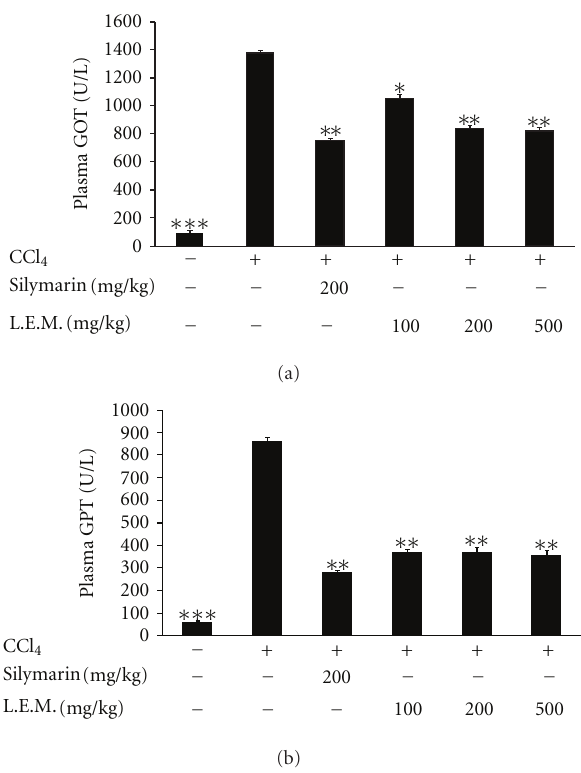
Figure 2: E ff ect of LEM on plasma GOT and GPT levels in CCl 4 - treated rats. (a) Changes of plasma GOT by oral administration of LEM in CCl 4 -treated rats for 8 weeks. (b) Changes of plasma GPT by oral administration of LEM in CCl 4 -treated rats for 8 weeks. Lane 1: vehicle-treated Wistar rats; lane 2: vehicle-treated CCl 4 -induced rats; lane 3: silymarin- (200mg/kg) treated CCl 4 - induced rats; lane 4: LEM- (100mg/kg) treated CCl 4 -induced rats; lane 5: LEM- (200mg/kg) treated CCl 4 -induced rats; lane 6: LEM- (500mg/kg) treated CCl 4 -induced rats. Data represent mean ± SEM of eight animals. ∗ P < 0 . 05, ∗∗ P < 0 . 01, and ∗∗∗ P < 0 . 001 compared with CCl 4 -induced group receiving